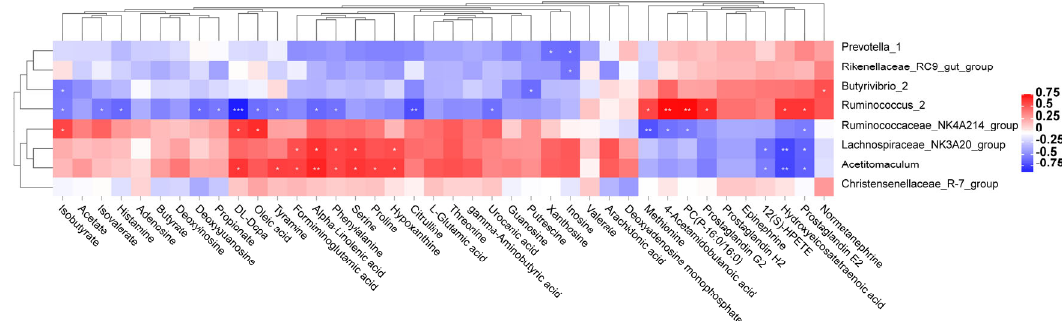
Figure 6. Correlation coefficients between rumen bacterial genera and rumen differential metabolites (derived from Table 3). Each column in the graph represents a genus, each row represents a metabolite, and each cell represents a Pearson correlation coefficient between a genus and a metabolite. Red indicates a positive correlation, and blue represents a negative correlation. p * < 0.05; ** p < 0.01; *** p < 0.01.